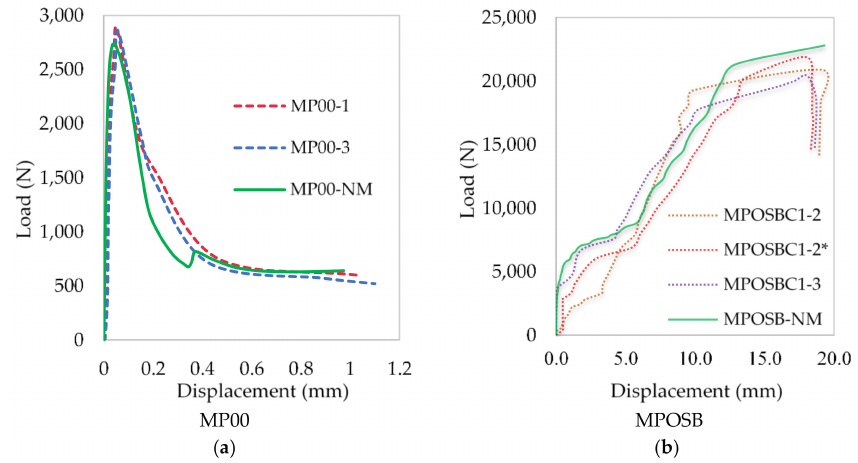
Figure 17. Load–displacement curves (experimental and FE model) of: ( a ) plain MP, ( b ) MP with OSB panels. MPOSBC1-2* was constructed to replace the damaged